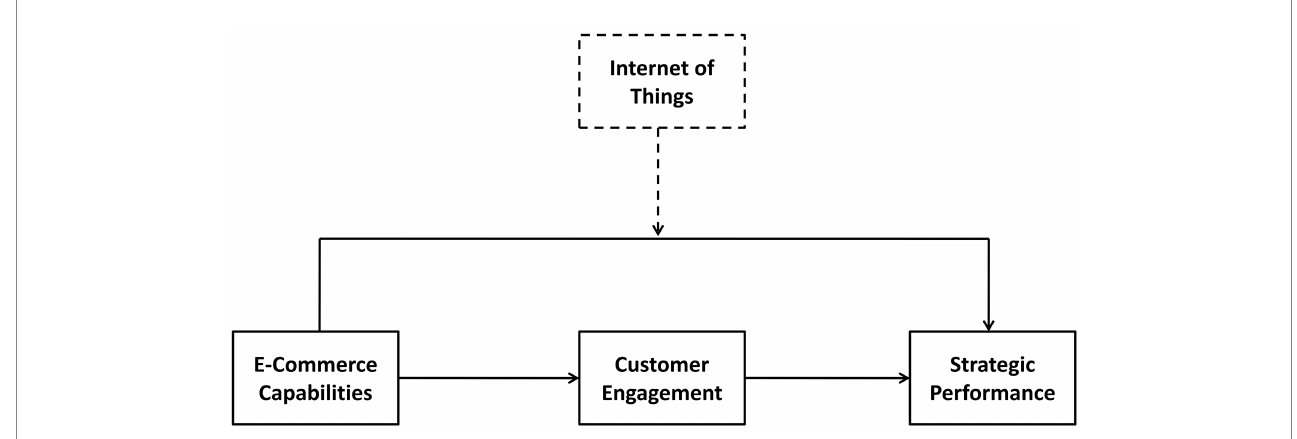
FIGURE 1 Theoretical